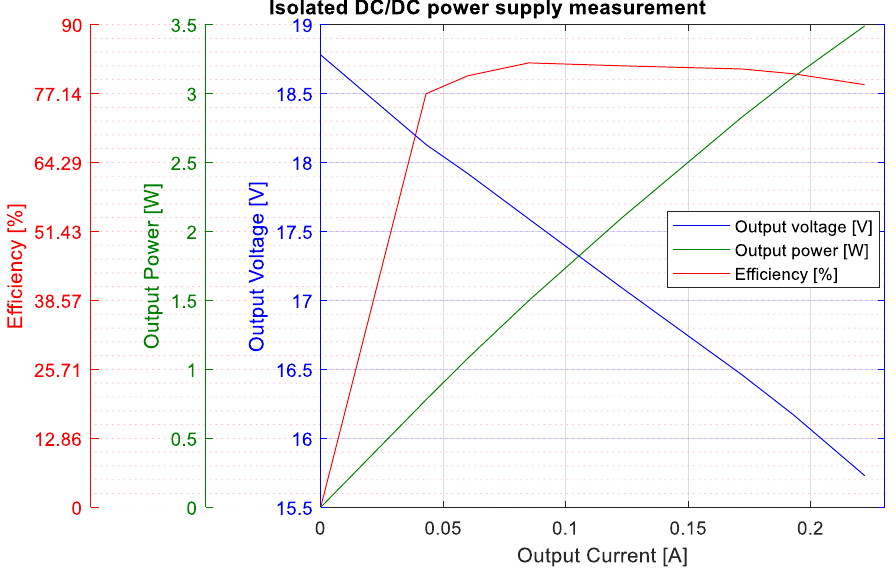
Figure 11. Measured characteristics of the designed isolated power supply.